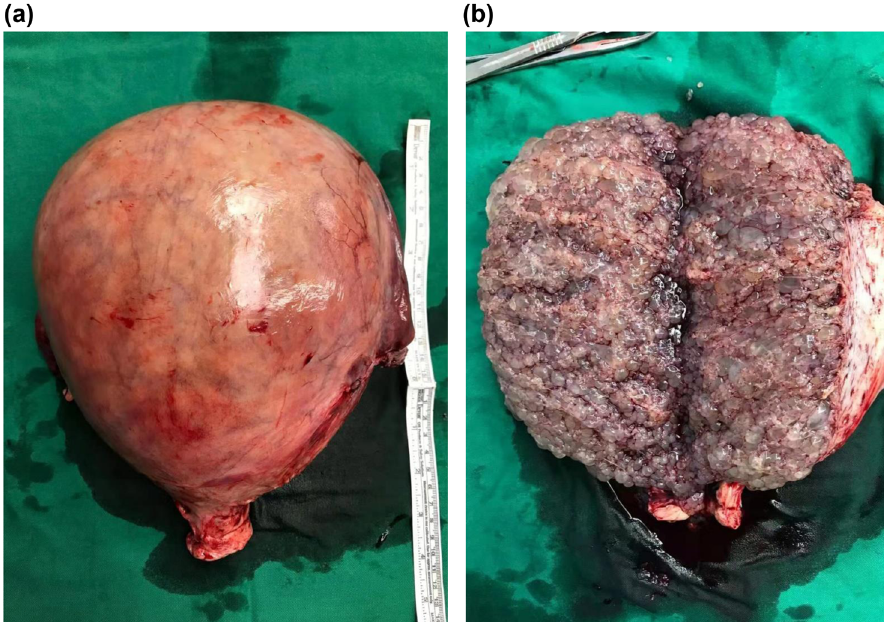
Figure 2: Macroscopic view of surgically removed uterine. ( a ) The size of the surgically removed uterine was 28 cm × 25 cm × 18 cm and weighed about 2,650 g. ( b ) The uterine cavity was fi lled with transparent grapelike tissue and the relationship with the muscular layer was still